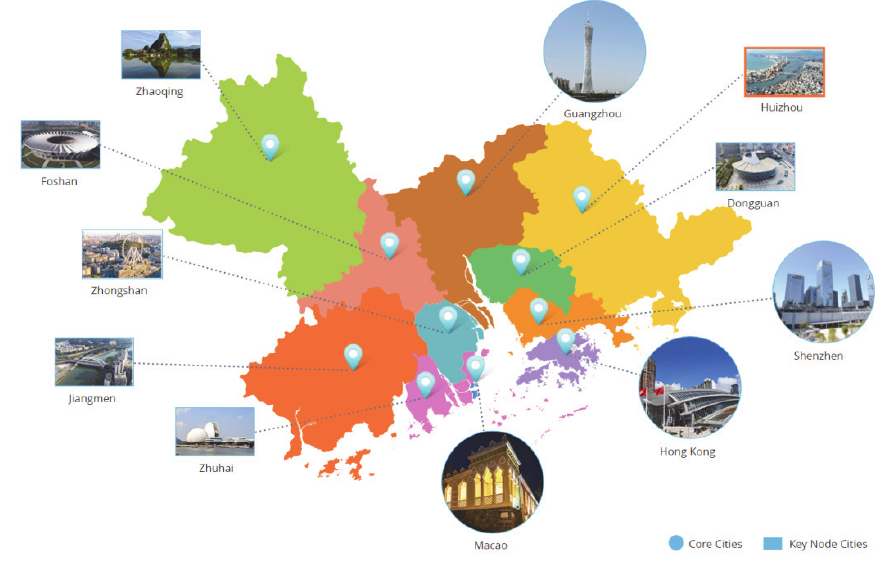
Figure 1. The GHM-GBA’s core cities and key node cities.